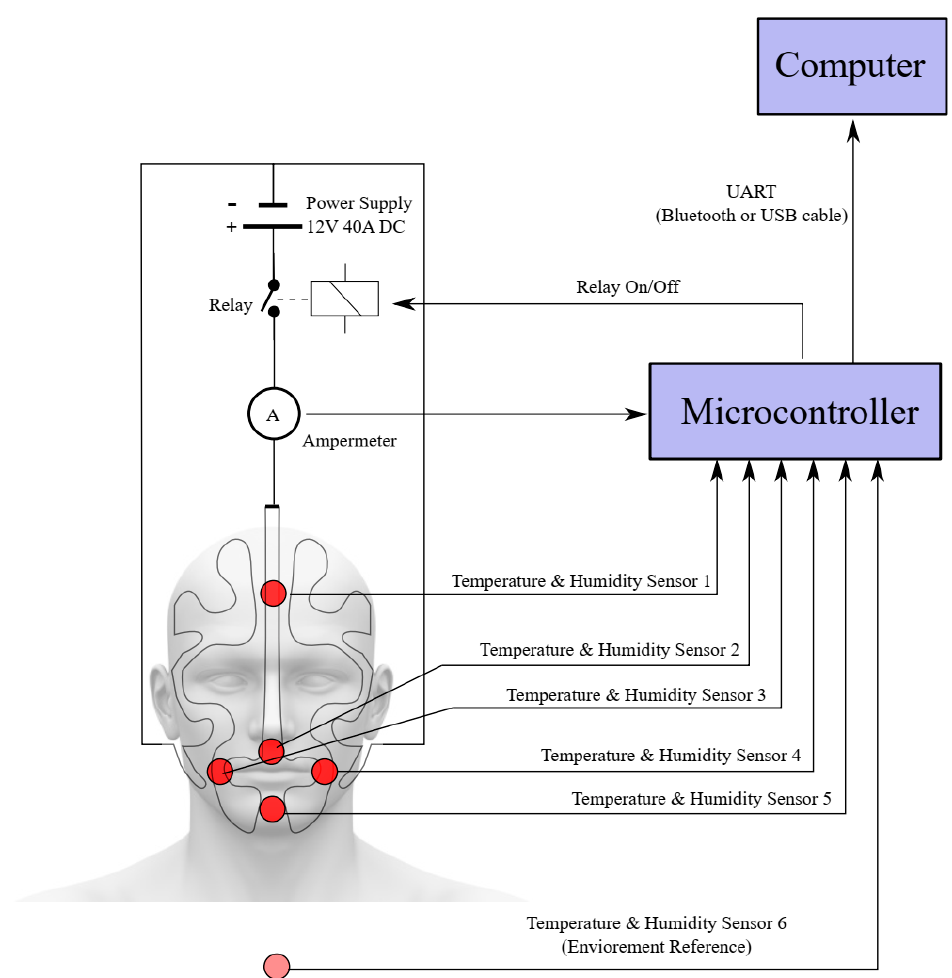
Figure 3. Head model wiring diagram.